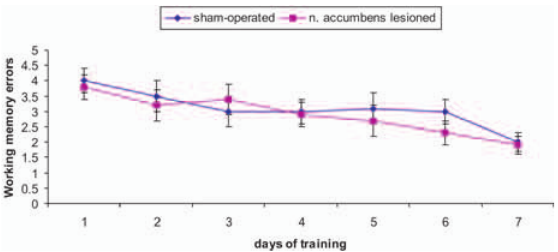
Figure 2. Cell cytotoxicity after exposure of the HUVEC cultures to artificial saliva (a) respective conditioned saliva with biomaterial E1 (b), E4 (c), and E5 (d) for 24 and 72 hours (results are shown as % of untreated controls). Panels are representative of three independent experiments; p ≤ 0.05 was considered significant.